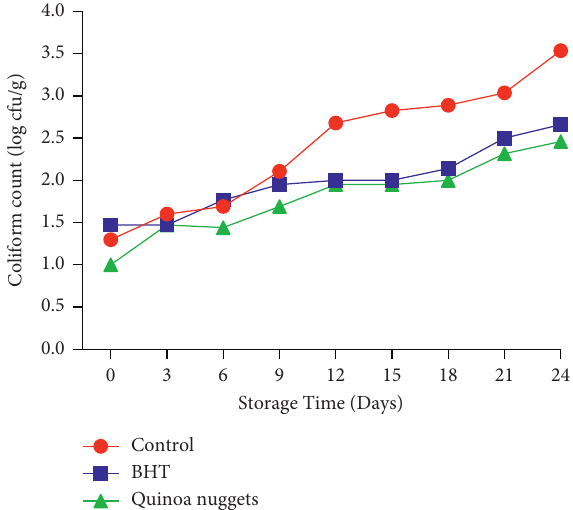
Figure 6: Coliform count (log cfu/g) of chicken nugget samples during storage at 4 ° C for 24 days. —permissible limit should not exceed 10 2 cfu/g according to Egyptian Standards [19] for meat poultry products.